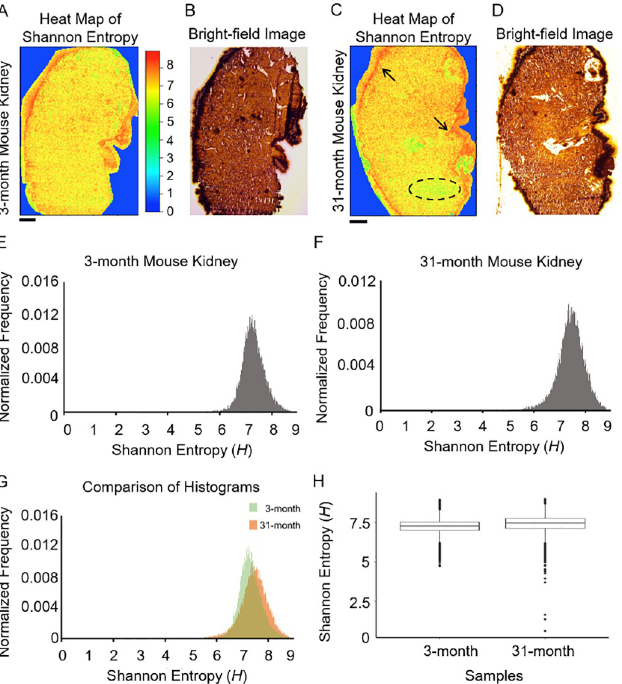
Fig 2. Shannon entropy for the two kidneys. Entropy heat maps ( A and C ) and bright-field images ( B and D ) are shown for the 3- and 31-month mouse kidneys, respectively. Black arrows show examples of high entropy regions. A low-entropy region which appeared only for the 31-month kidney was marked by a black dashed oval. ( E and F ) Histograms of the Shannon entropy of two samples. ( G ) The two histograms were superimposed. ( H ) Box plots for the 3- and 31-month kidneys. Scale bars denote 1